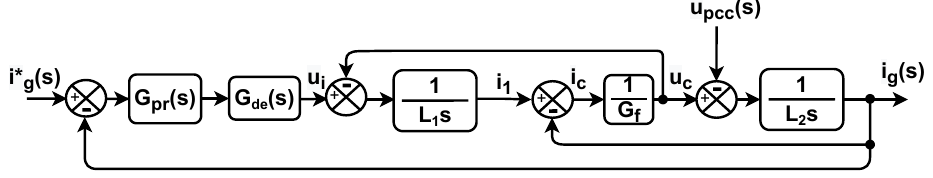
Figure 8. Control block diagram of grid current control for LCL grid–connected